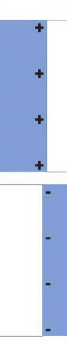
Fig. 1: Two complementary models consisting of blocks of air and water representing the membranous and aqueous media in cellular systems. a) Air block confined by two water blocks. b) Water block confined by air blocks. The external electrode charges influence charges in water but not in air. Induced charges are drawn for DC or AC for the half-wave during which the left electrode is positively charged.